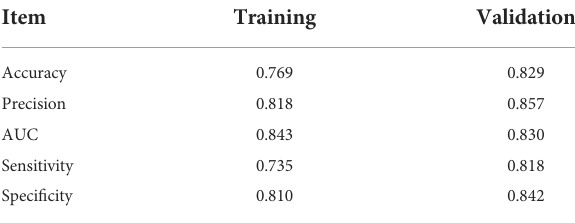
TABLE 5 Evaluation of the KNN in the training and validation samples.